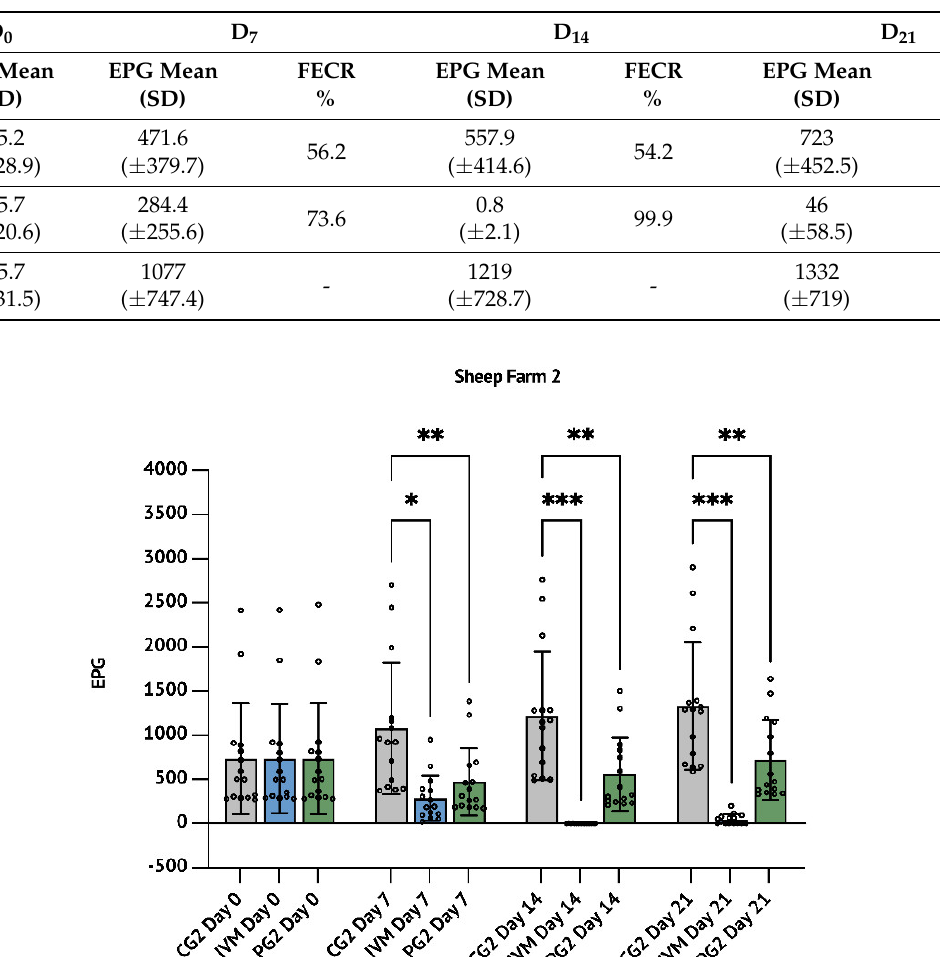
Table 3. Percentage of sheep nematode third-stage larvae (L3) for each group at D0, D7, D14 and D21 in sheep farm 1 (SF1); PG1 treated aqueous P. granatum macerate group 1 (50/mL/OS as a single dose); ALB treated Albendazole group (3.75 mg/Kg/BW/OS as a single dose); CG1 untreated control group 1.